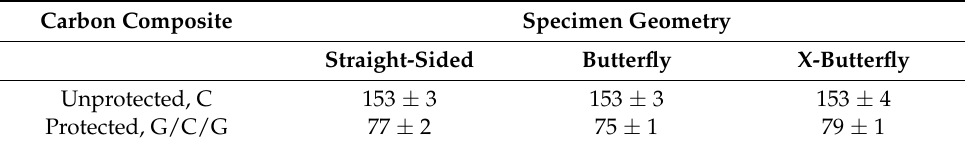
Table 2. Initial stiffness (GPa) of unprotected (C) and protected (G/C/G) carbon composites with three specimen geometries.